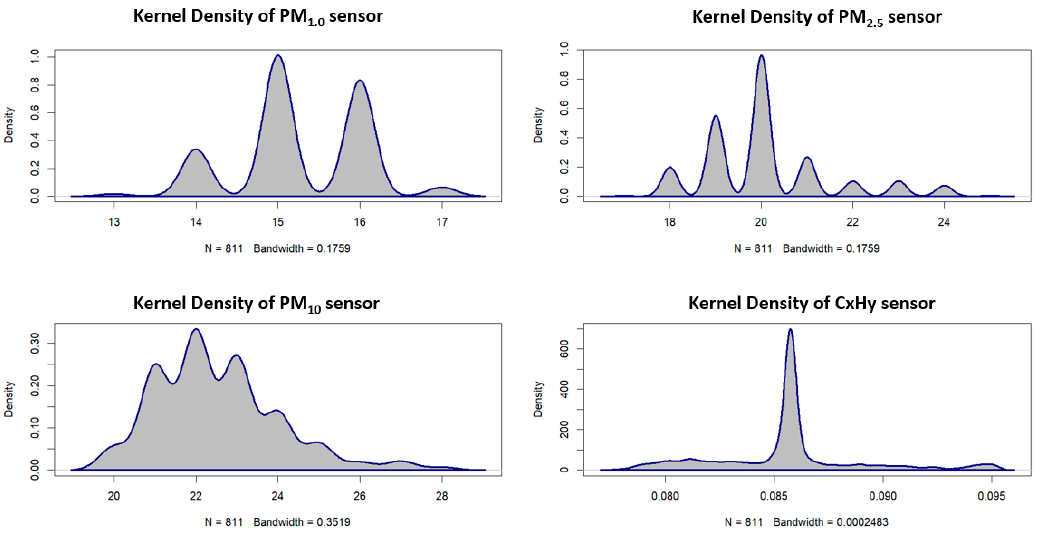
Figure A4. Kernel density for second ground measurement (VOCs sensor, SO 2 sensor, CO sensor, O 3 + NO 2 sensor).